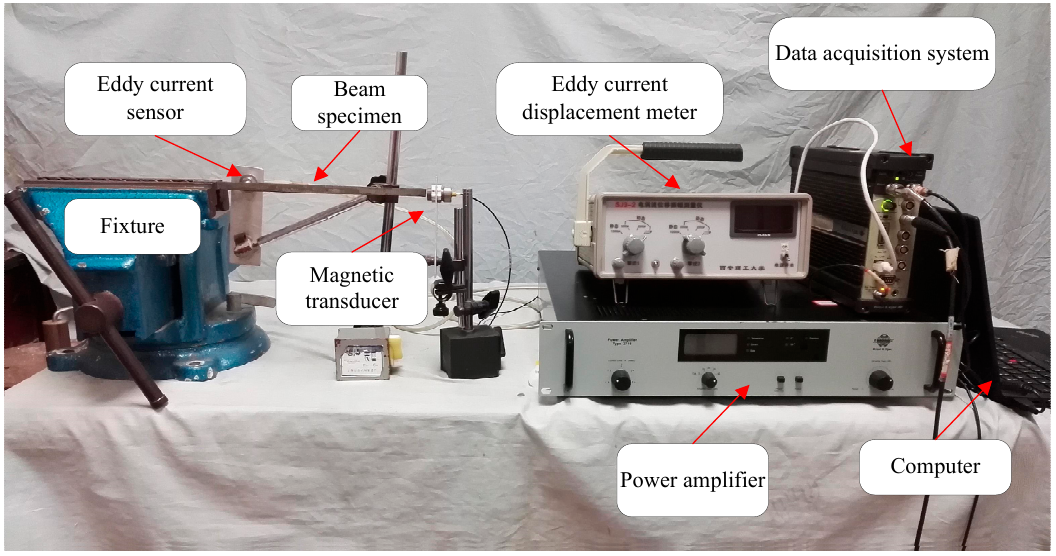
Figure 6. Experimental setup.